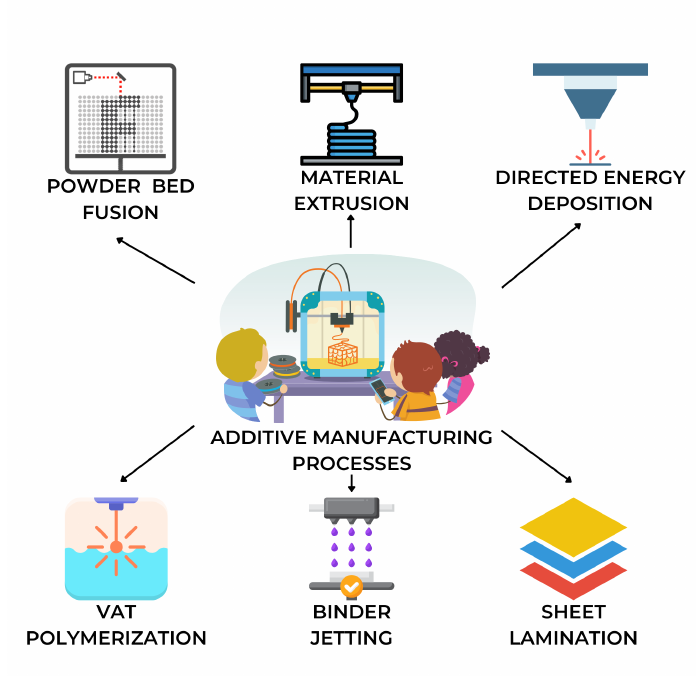
Figure 1. Additive manufacturing comes in many forms. Powder bed fusion, material extrusion, directed energy deposition, vat polymerization, binder jetting, and sheet lamination are the main processes in additive manufacturing.